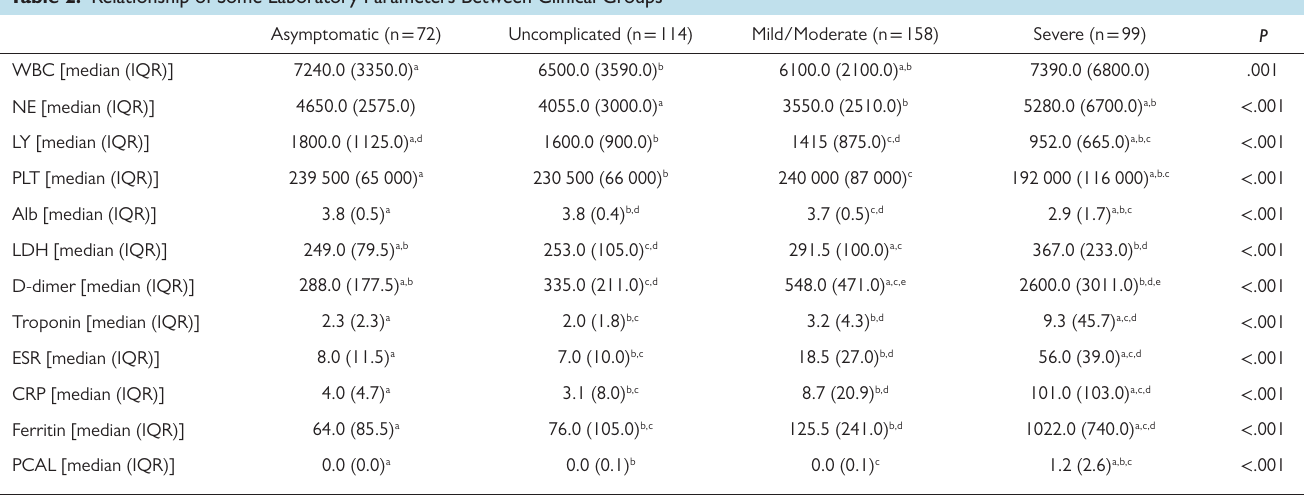
Table 2. Relationship of Some Laboratory Parameters Between Clinical Groups Asymptomatic (n = 72) Uncomplicated (n =